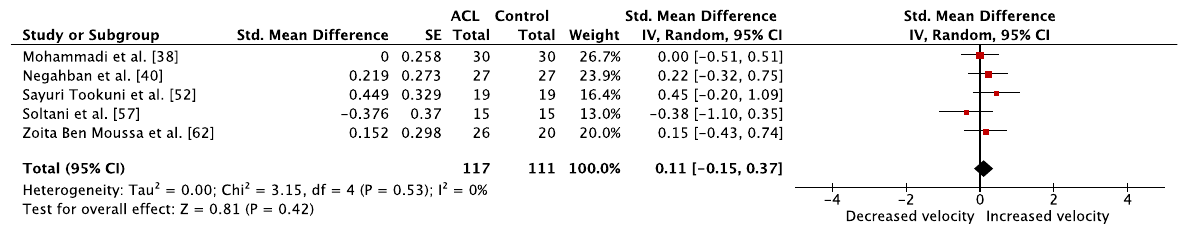
Fig. 7 Forest plot comparison of sway velocity between the ACL-non-injured leg and ACL-matched control leg. Std . standardized, SE standard error, IV inverse variance, CI confidence interval, df degrees of freedom, ACL anterior cruciate